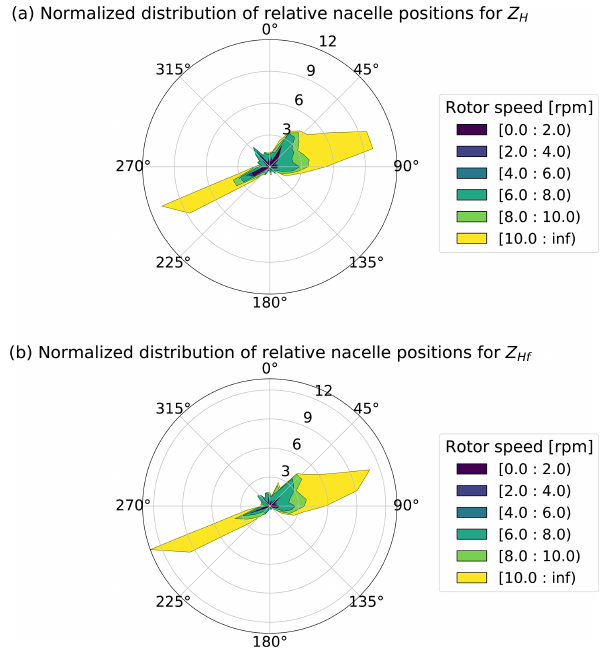
Figure 9. The plots indicate the normalized distribution of rela- tive nacelle positions with corresponding rotor speeds during March 2020 for the unfiltered Z H (a) and filtered Z Hf (b) reflectivity data. The rotor speeds are binned with a width of